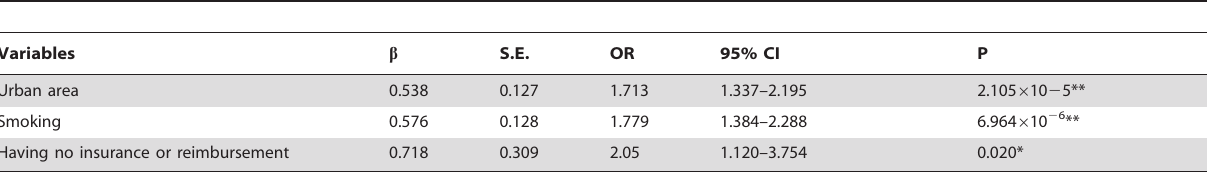
Table 3. Multivariate logistic regression analysis of potential risk factors in relation to prevalence of dental caries in an elderly population aged 65–74 years in northeast